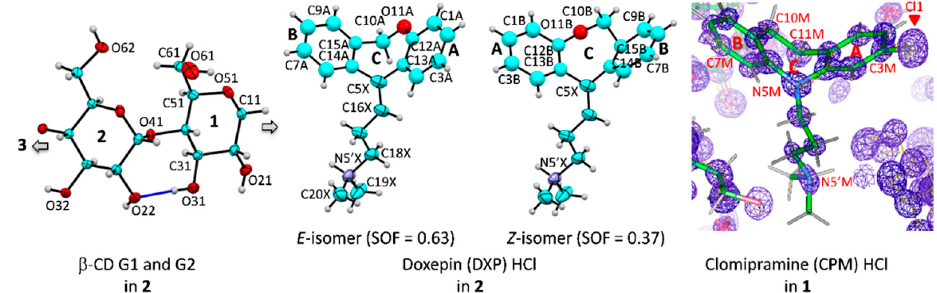
Figure 1. Atom numbering schemes of β -CD, DXP HCl, and CPM HCl; Oak Ridge thermal ellipsoid plot (ORTEP) plots at 30% probability level. In 1 and 2 , CPM and DXP are protonated at N5’ and counterbalanced by twofold disordered chlorides (not shown here). ( Left ) The connecting blue lines indicate the intramolecular, interglucose O3( n ) · · · O2( n + 1) hydrogen bonds stabilizing the round β -CD conformation; see also Figures 2–4. ( Middle ) For 2 , the DXP tricyclic moiety is doubly disordered with sites A and B having site occupancy factors (SOFs) of 0.63 and 0.37 for the E and the Z isomers, respectively. ( Right ) For 1 , the experimental F o electron density map (contoured at 1.8 σ ) clearly shows that the chloro group is located merely on C3 of the CPM A-ring (not on C7 of the B-ring). The map was created using WinCoot [27].